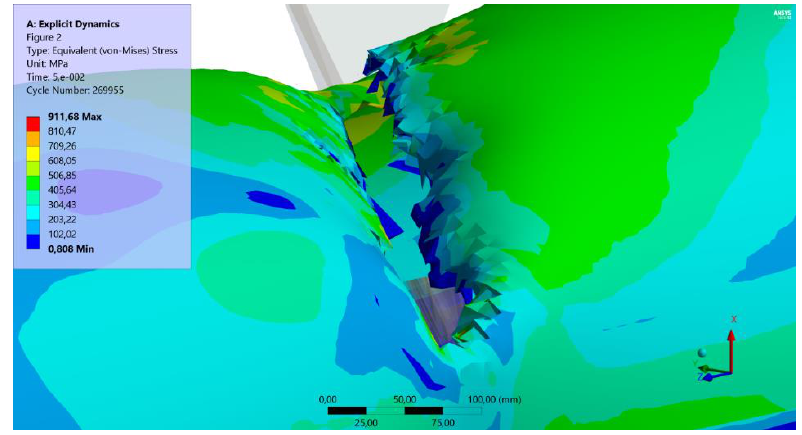
Figure 12. Pipeline damage for Variant 3—effective stress values.